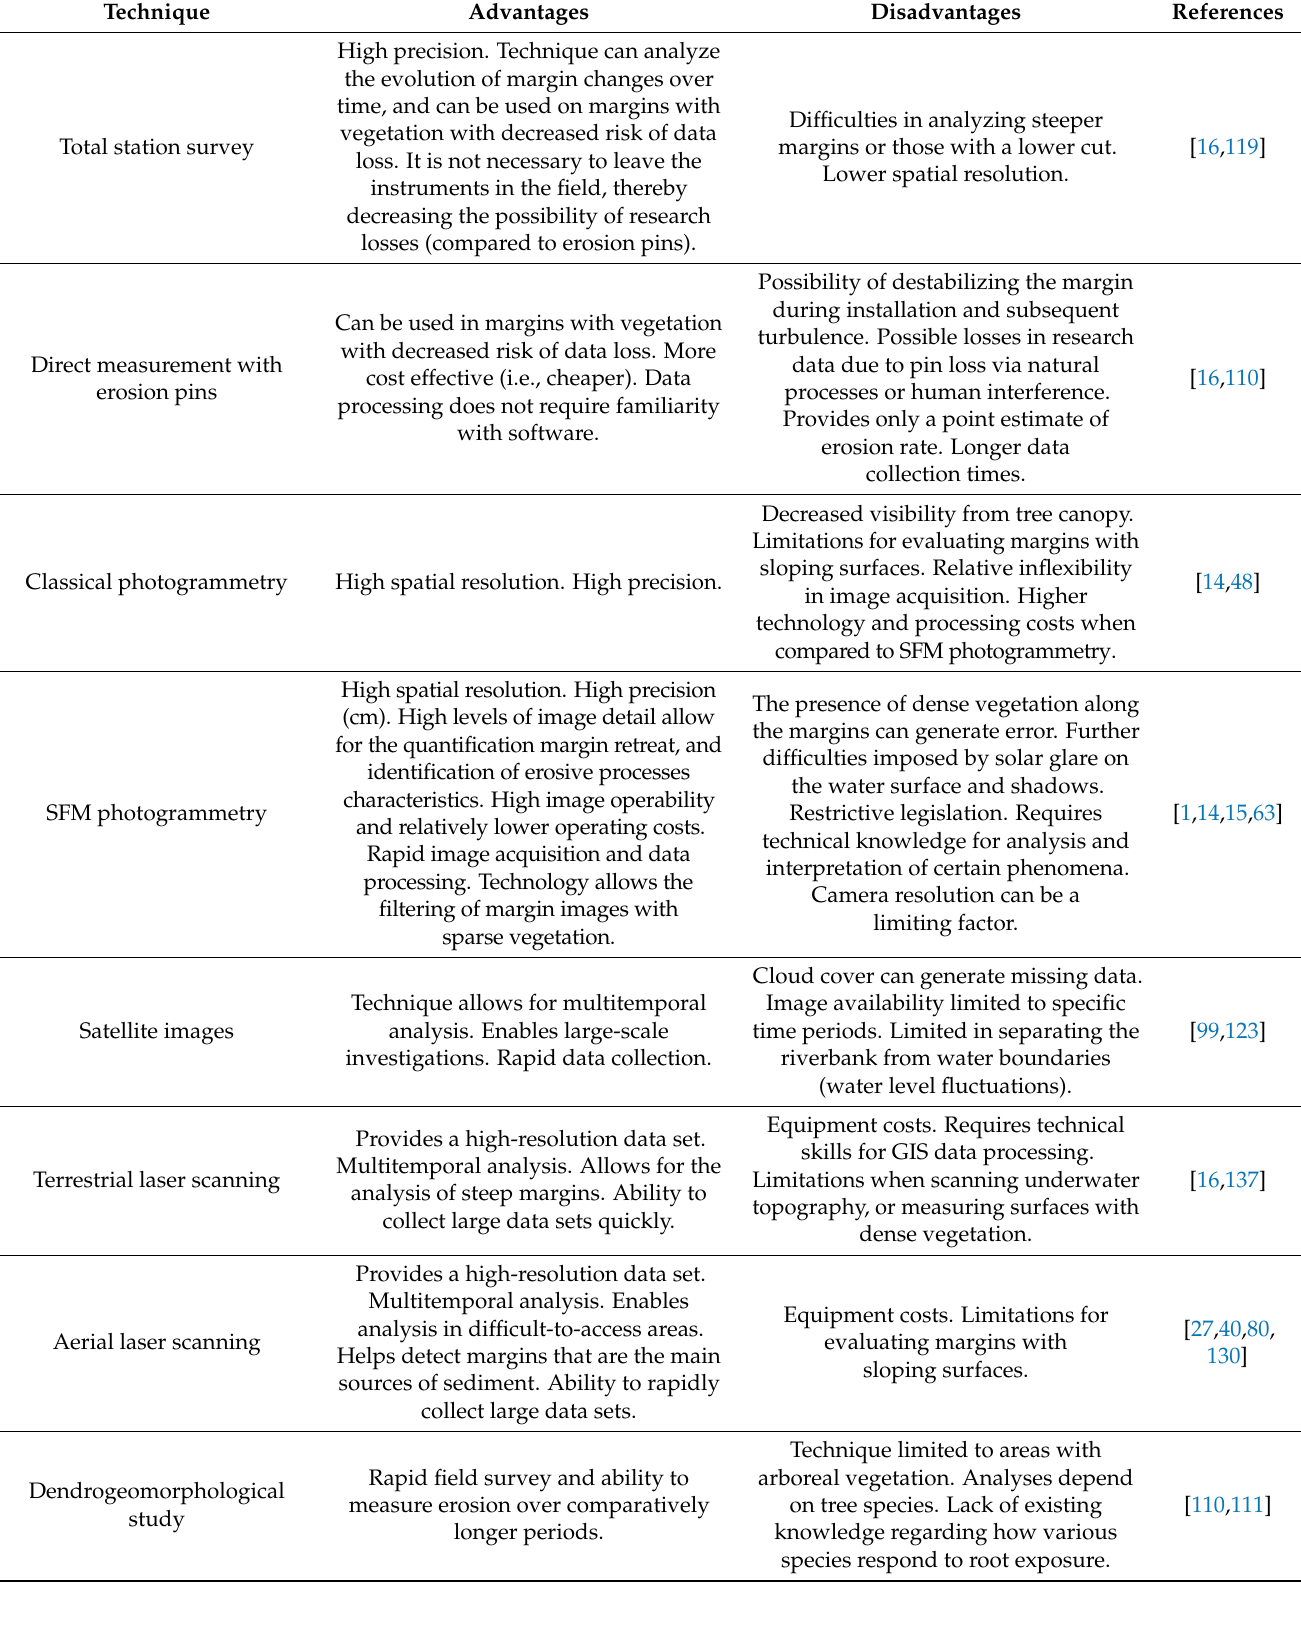
Table 4. Comparative analysis of field techniques for measuring erosion in